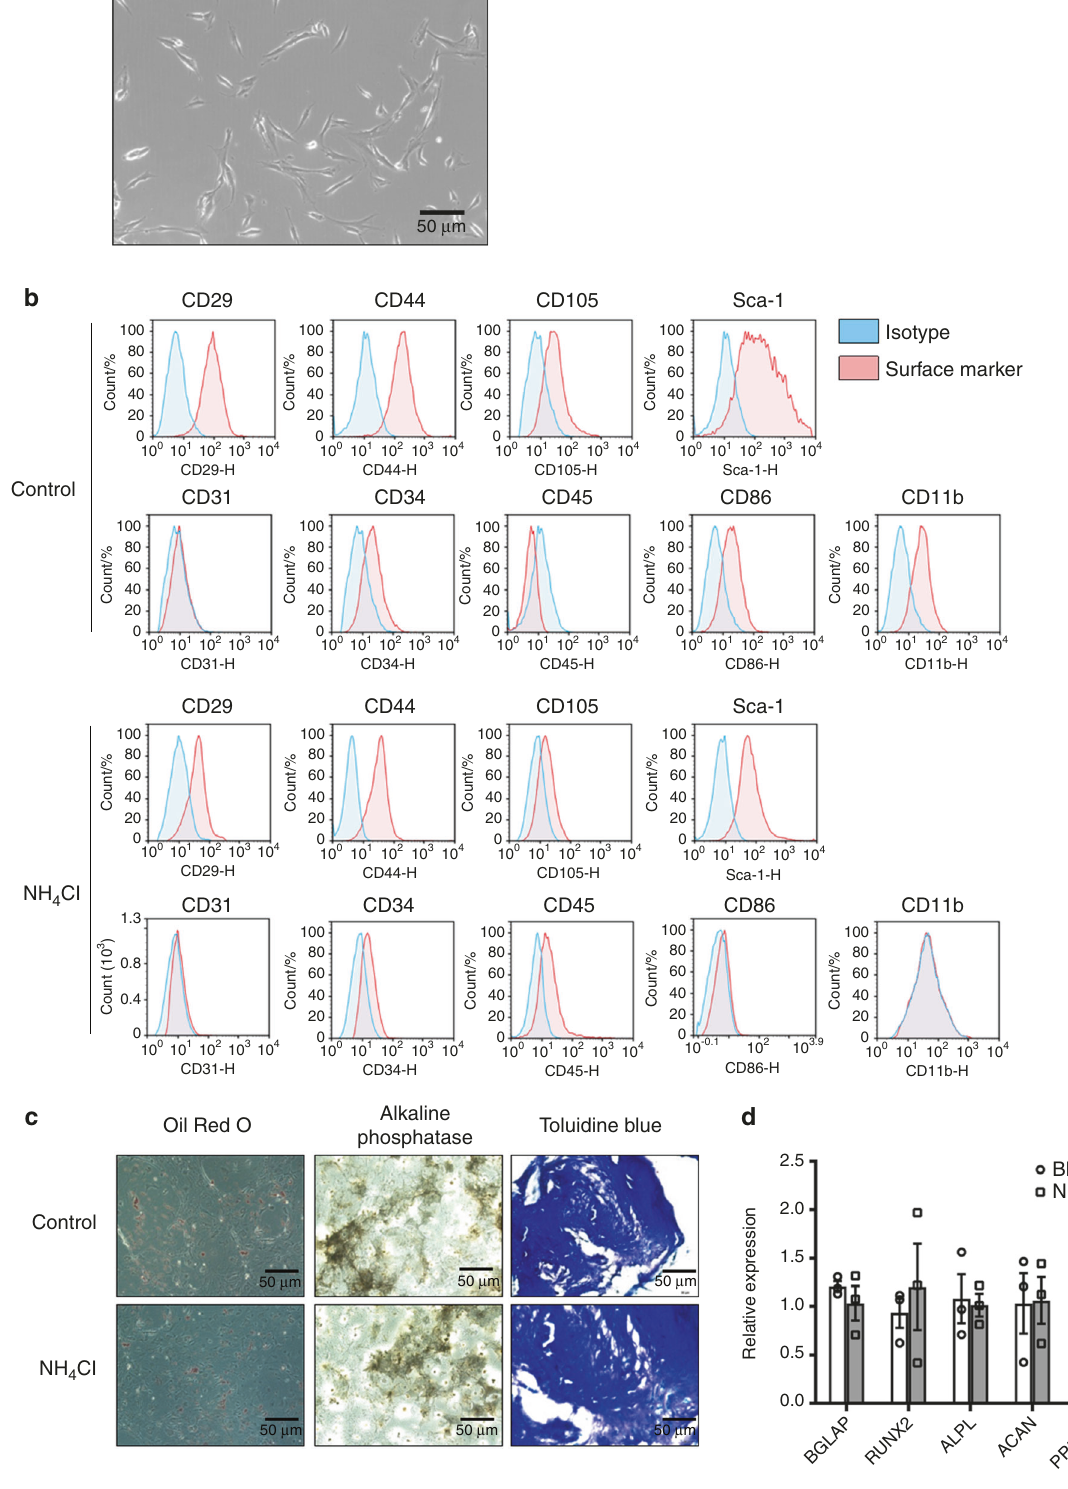
Fig. 1 Isolation and identi fi cation of mesenchymal stem cells from mouse bone marrow. a Fibroblast-like or spindle-shaped morphology of mesenchymal stem cells appears at passages 4 – 6. b Passage 4 – 6 cells were harvested and stained with positive surface markers of mouse BM- MSCs: CD29, CD44, CD105, and Sca-1 and negative markers: CD31, CD34, CD45, CD86, and CD11b with their corresponding isotype control via FACS analysis. c Adipogenesis of MSCs was observed with oil red O staining, osteoblastogenesis was assayed with in situ alkaline phosphatase staining, and chondrocytic cells were identi fi ed with toluidine blue staining. d RT-PCR results showing the relative expression of bglap, runx2, alpl, acan and pparg with or without NH 4 Cl